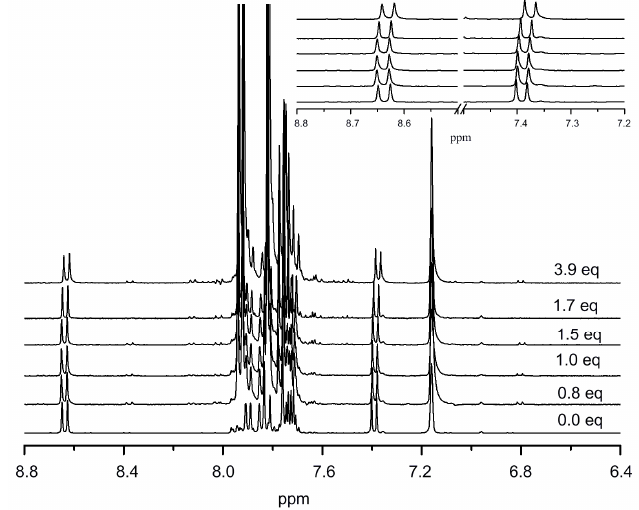
Figure 10. 1 H NMR experiments of gradually adding pyrene to Ti3 solution in C 6 D 6 .